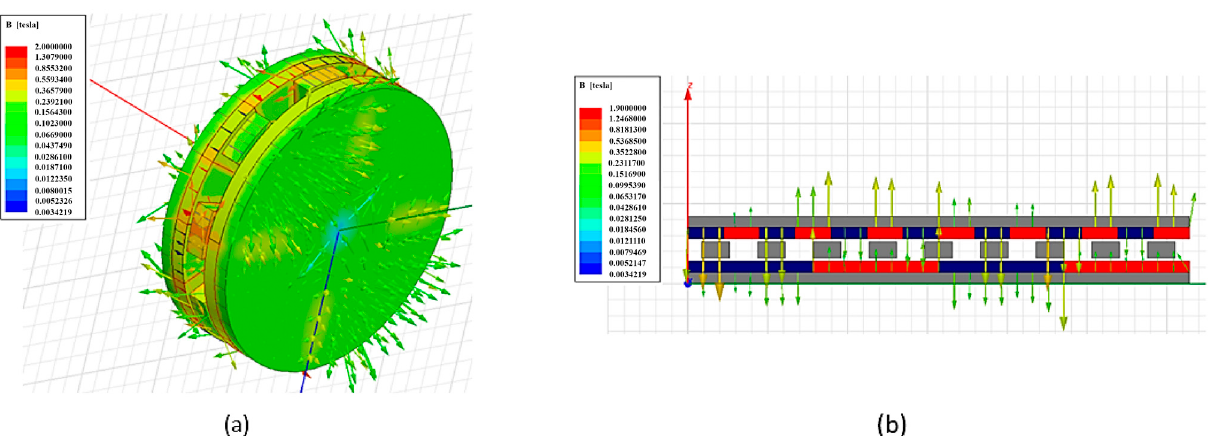
Figure 9. Flux density distribution and its direction: ( a ) 3D model; ( b ) 2D model.